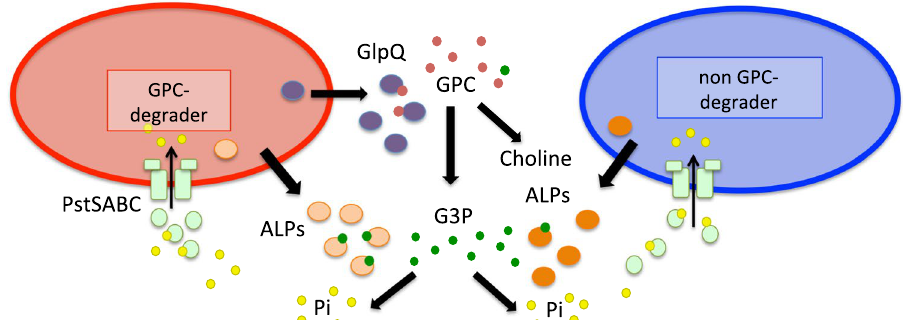
Figure 3. A proposed model for the metabolic steps of glycerolphosphorylcholine (GPC) degradation among Pseudomonas strains. Each cleavage step occurs either in the periplasm or extracellularly resulting in the production of free inorganic orthophosphate (Pi). Cells can then take up the Pi through Pi-specific transporters. Abbreviations: ALPs, alkaline phosphatases; PstSABC, high-affinity Pi transporter; other abbreviations are as stated in the previous